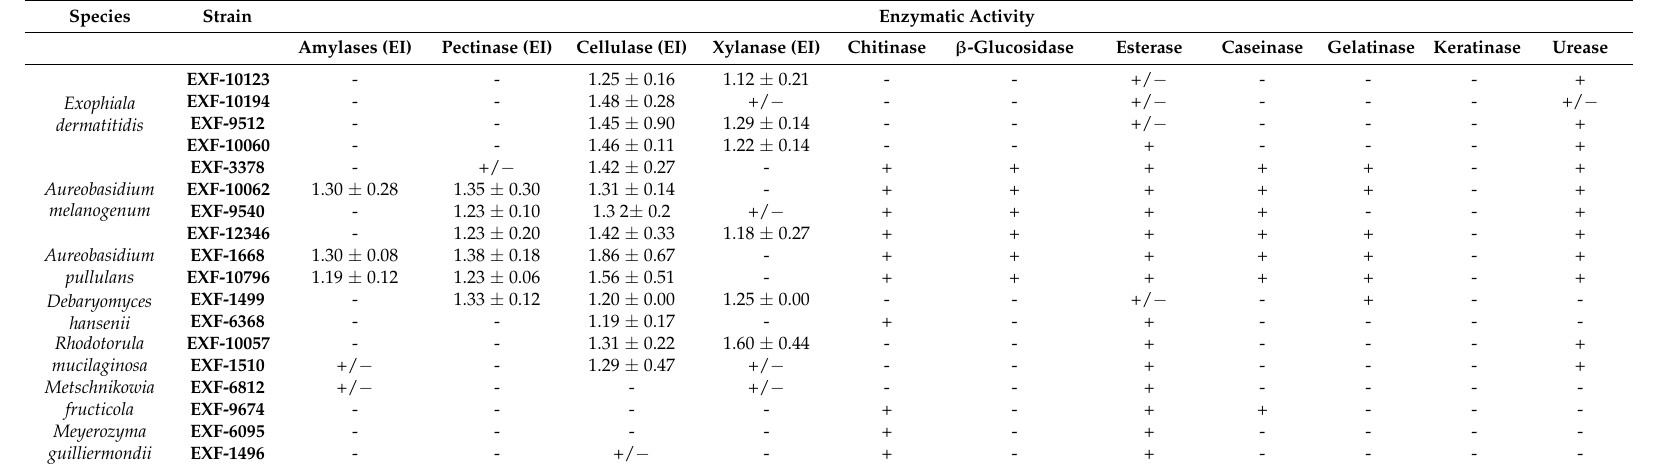
Table 3. Enzymatic activities of the selected yeast